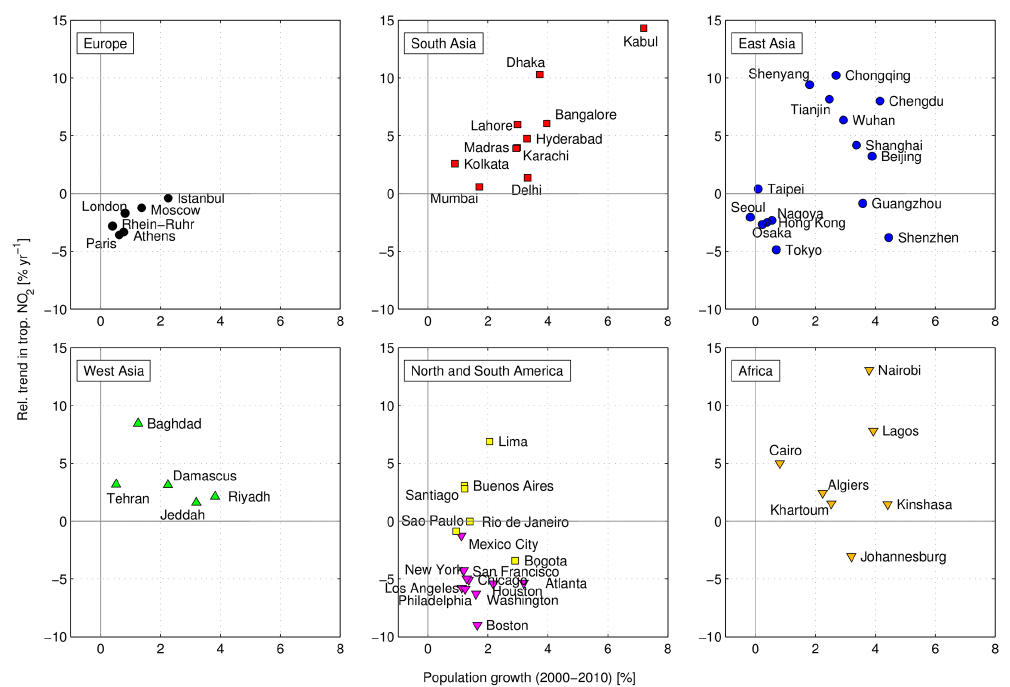
Figure 8. Relationship between population growth for the period 2000 and 2010 and SCIAMACHY-derived trends in tropospheric NO 2 for 2002 to 2012, by region. North and South America were combined into a single panel, where data points in North America are shown as pink triangles and data points in South America are shown as yellow